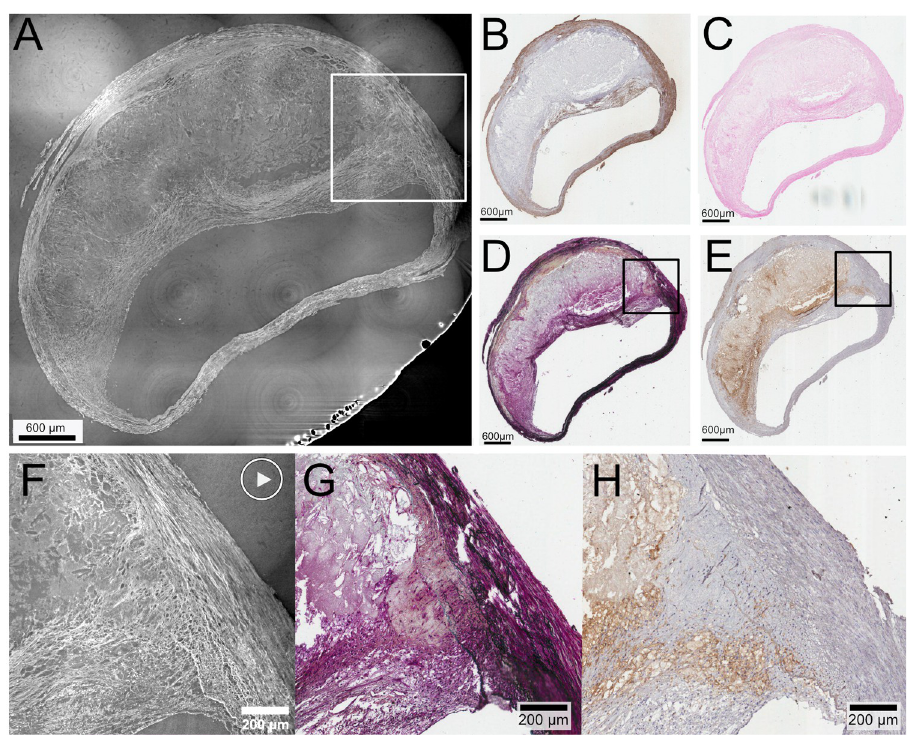
Fig 4. Stitched HR SR μ CT showing full axial plane of plaque with the shoulder region zoomed in (white square in A, black square in D and E). Full axial plane of plaque with stitched HR SR μ CT (A) and corresponding section plane in histology with four different stains on consecutive sections. (B) Alpha actin staining for smooth muscle cells. (C) von Kossa staining for calcifications (no calcifications present). (D) Movat staining for collagen, elastic fibers, nuclei, fibrin, mucins. (E) CD68 for macrophages. The box in (A) indicates the shoulder region, zoomed in on HR SR μ CT in (F) . (G) and (H) are the corresponding area shown with the black boxes in (D) and (E) for the Movat and CD68 staining. The "play" symbol in (F) : online movie material (S8 Movie in S1 File) showing the HR tomographic image stacks of the shoulder region.